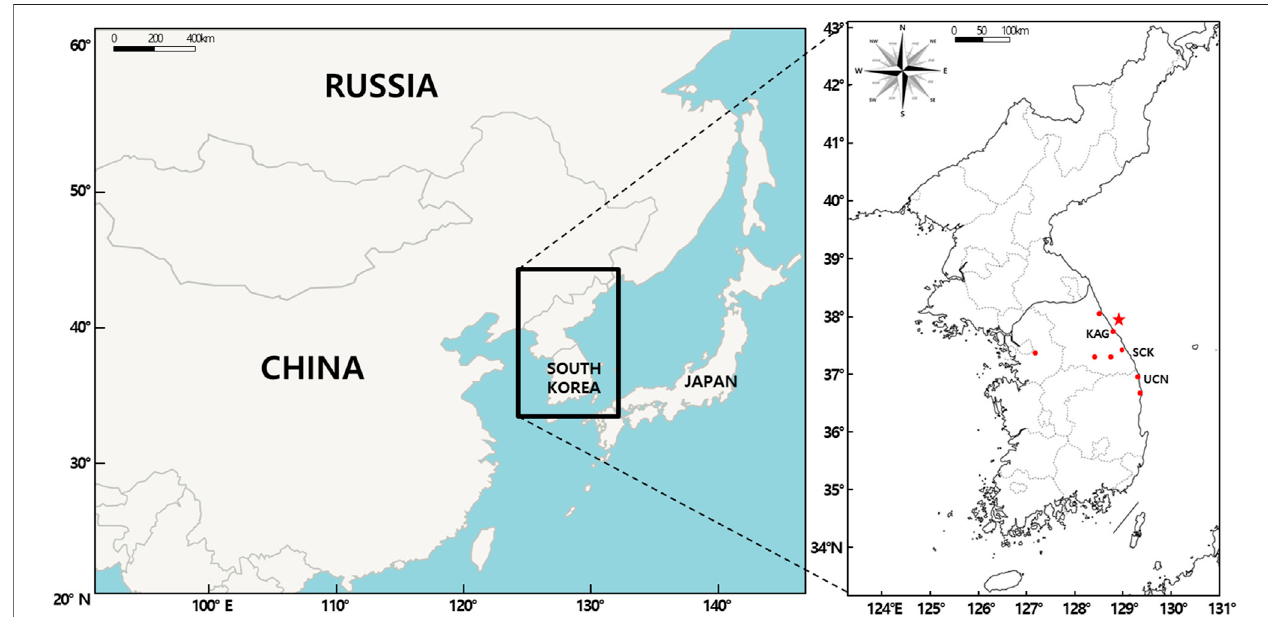
FIGURE 1 | Location maps showing the Korean Peninsula and the location of the epicenter (red star) of the mainshock of the 1681 earthquake in the East Sea, which caused a tsunami on the eastern coast of the peninsula.